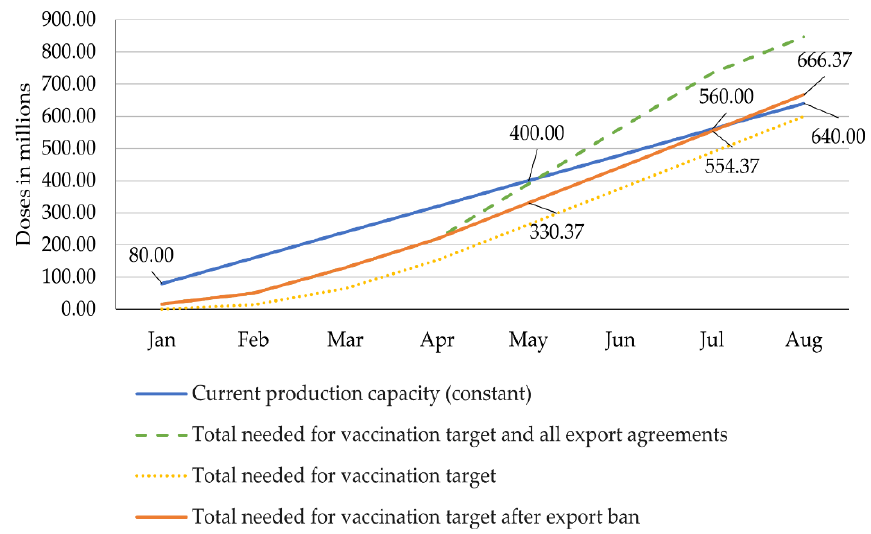
Figure 6. Constant production capacity vs. vaccine needs after export ban in April. Own illustration,